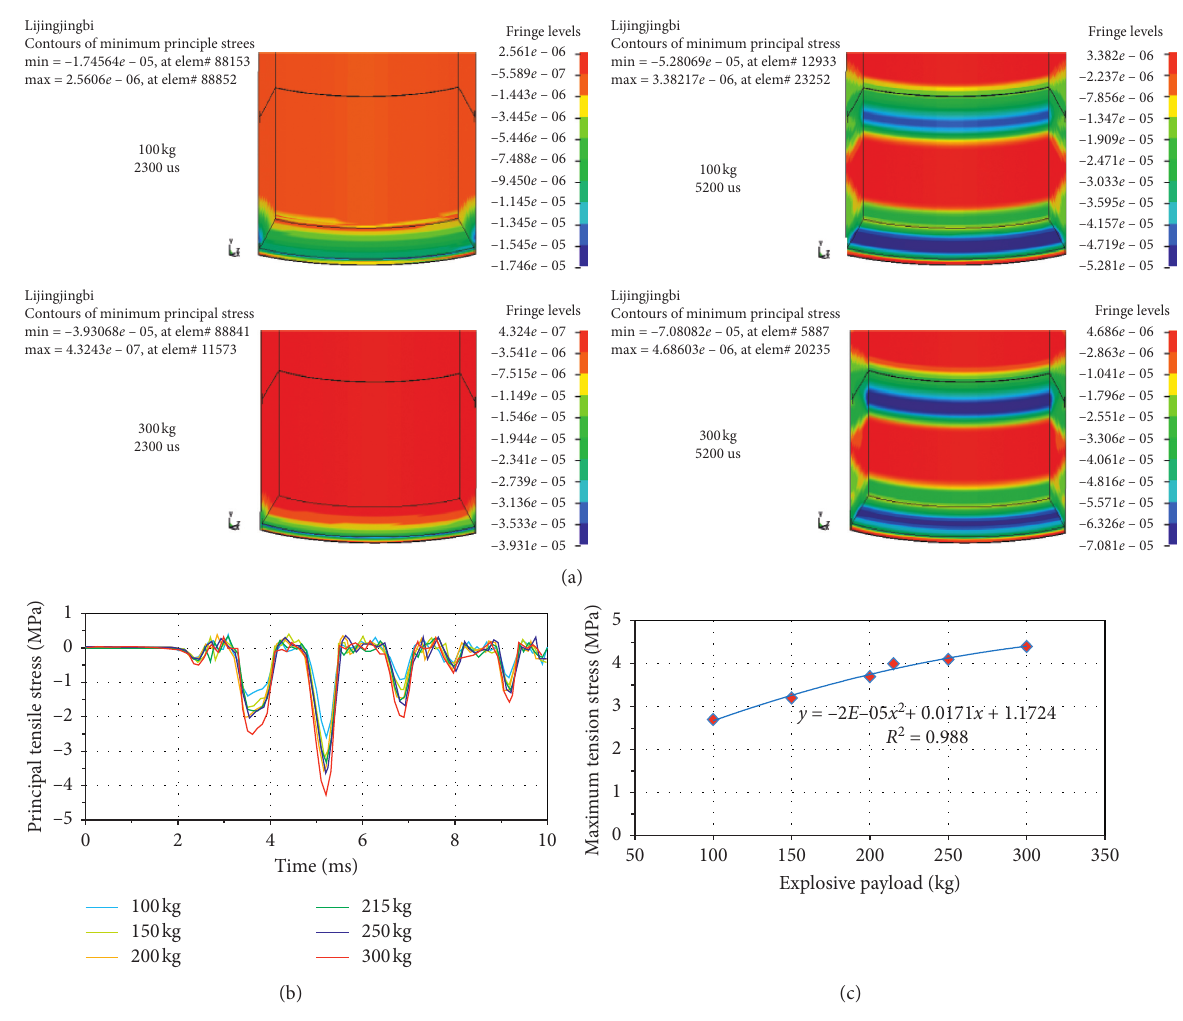
Figure 6: The relationships between principal tensile stress and explosive payloads. (a) Nephogram of the principal tensile stress at the center of the steel plate. (b) Principal tensile stress history curves with different explosive payloads. (c) Maximum tension stress with different explosive payloads in the steel